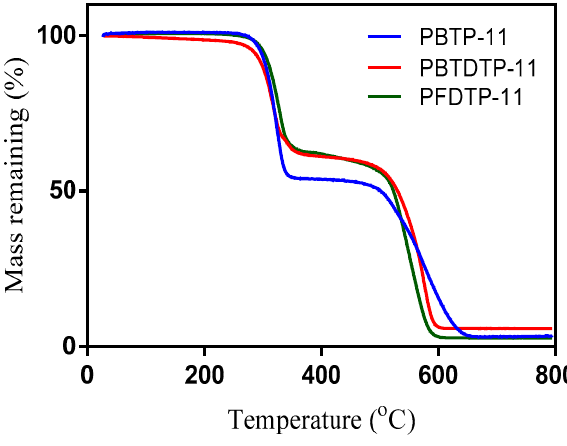
Figure 3. TGA of PBTP-11, PBTDTP-11 and PFDTP-11.